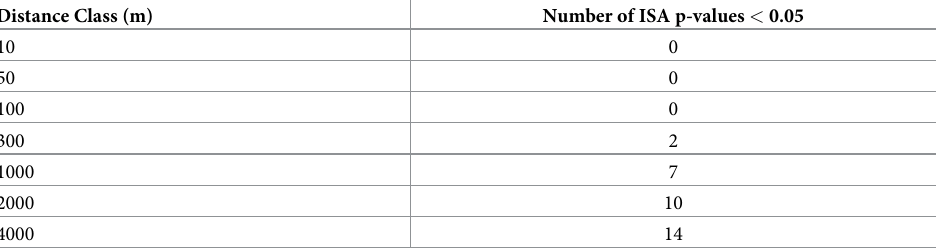
The MRPP A-statistic, a measure of the strength of community differences in multivariate species-space, showed two general clusters of plots—those between 10–100m and those � 1000 m (Table 4). The 300 m plots showed weak differences between each of these groups. Plots at the 1000, 2000 or 4000 m distances showed only weak lichen community differences among themselves (A = 0.02) but strong to moderate differences with plots in the 10–100 m distance group (0.05 � A � 0.20). A-statistics were the highest in comparing the 2000 m or 4000 m plots with those close to the road.